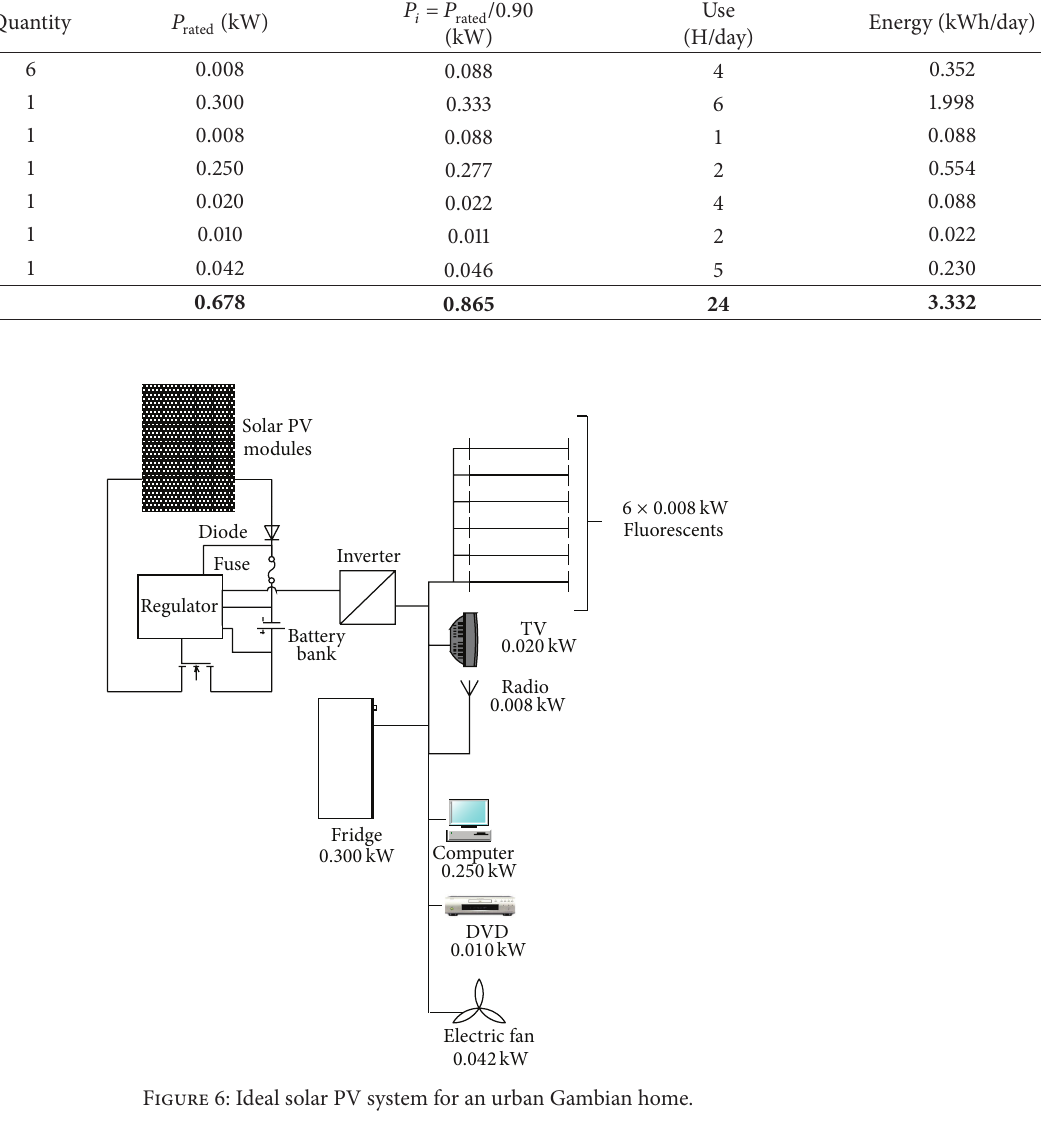
Table 1: Household load consumption data.